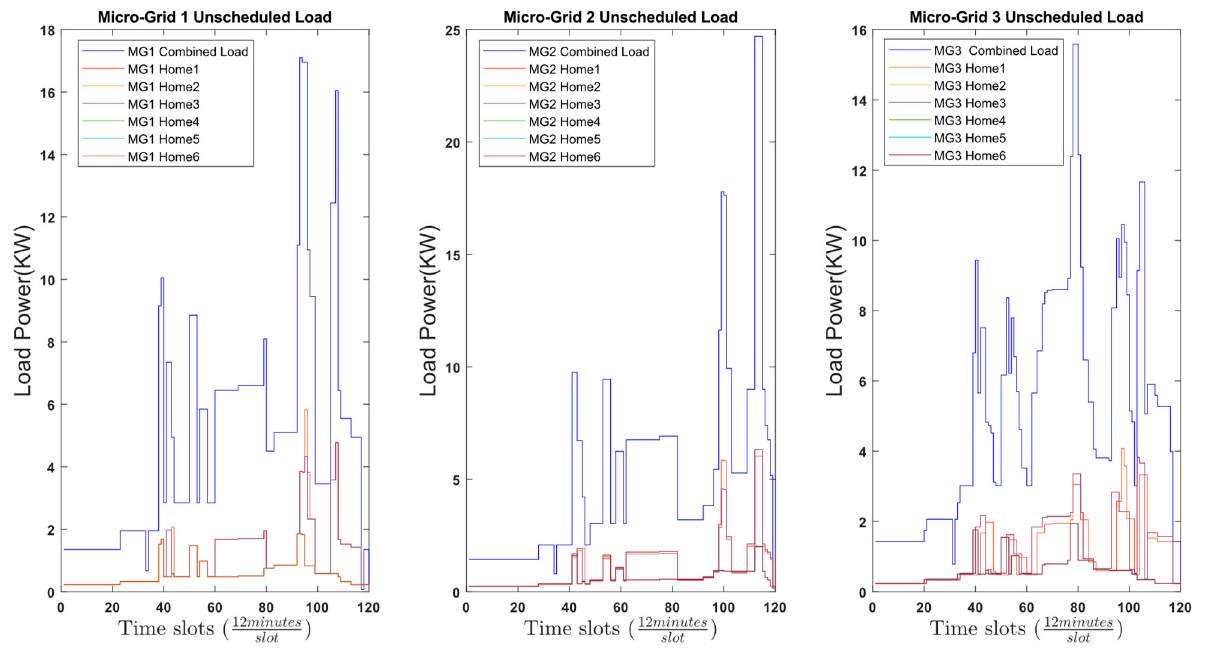
Figure 8. Load curve of MG 1 , MG 2 , and MG 3 with individual home demand.